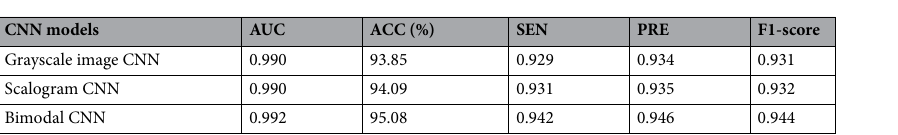
Table 3. Diagnostic performance comparison among grayscale image, scalogram, and proposed CNN models in lead II (learning rate = 1e−4).